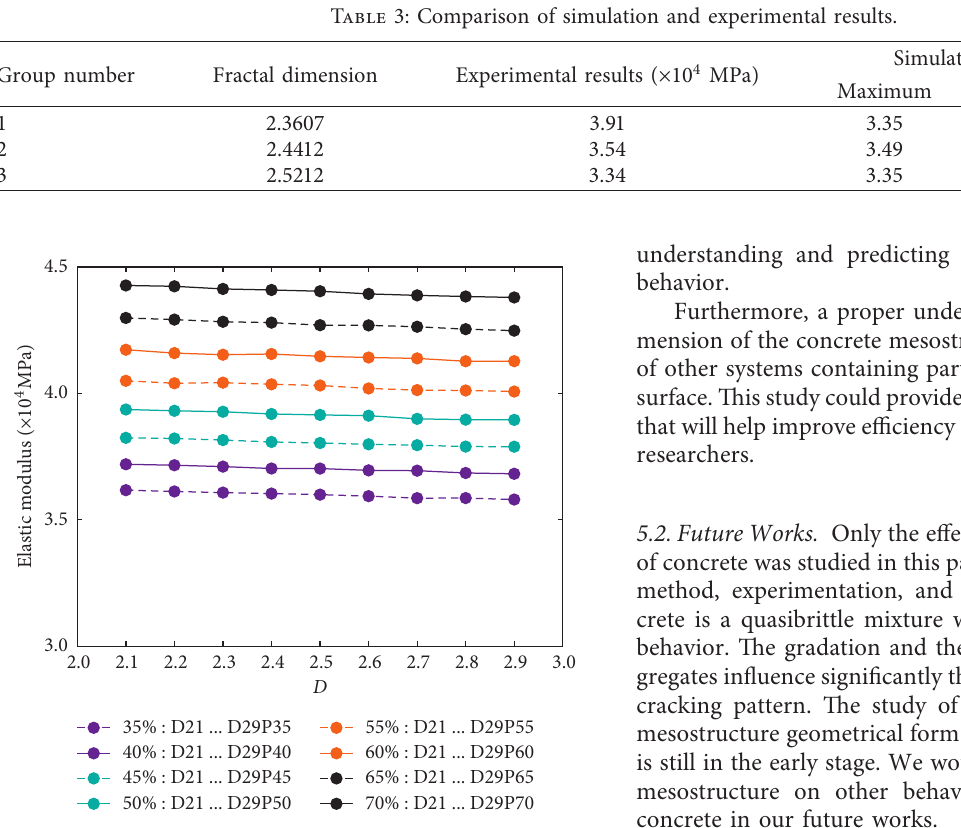
Figure 5: Effect of the geometric form of the mesostructure on the initial elastic